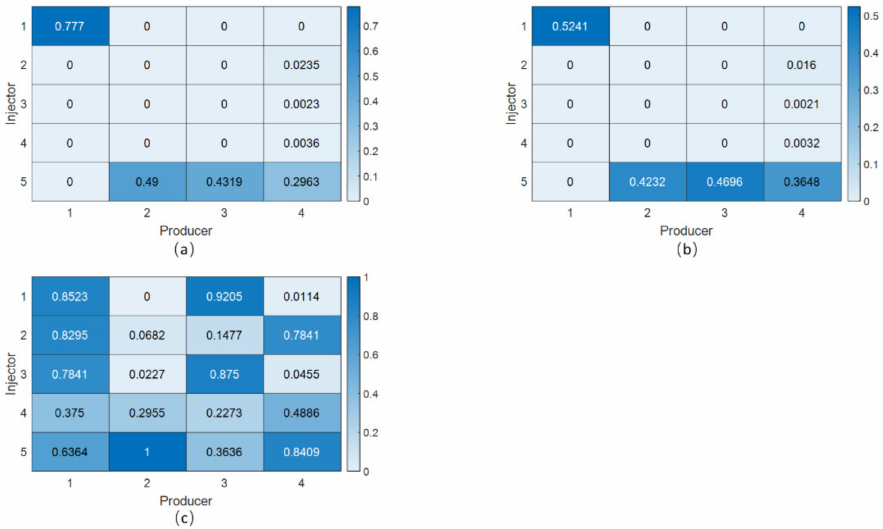
Figure 12. The heatmaps of the inter-well connectivity analysis by KINN-tansig and KINN-Gaussian for the streak reservoir case: ( a ) KINN-tansig; ( b ) KINN-Gaussian; ( c )